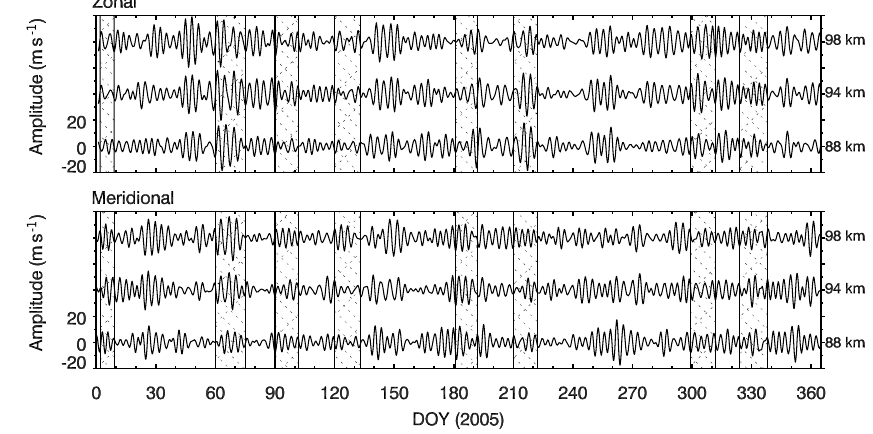
Figure 4. Band-passed zonal and meridional wind at 88, 94 and 98km. Cutoff periods are from 2.8 to 4.5 days.